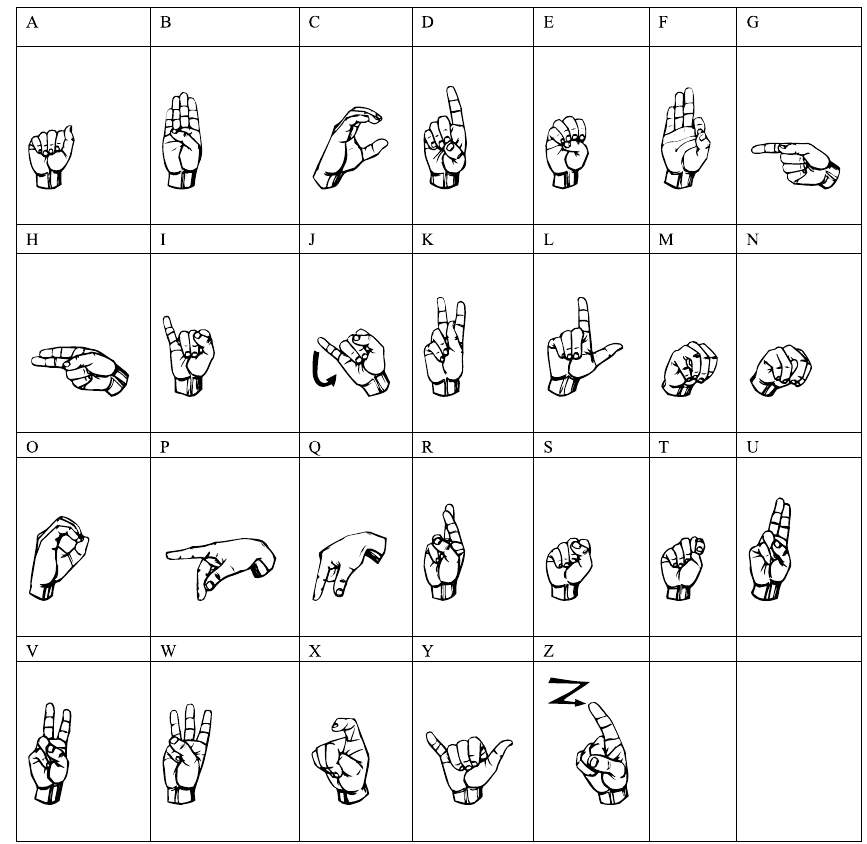
Figure A1. ASL Fingerspelling